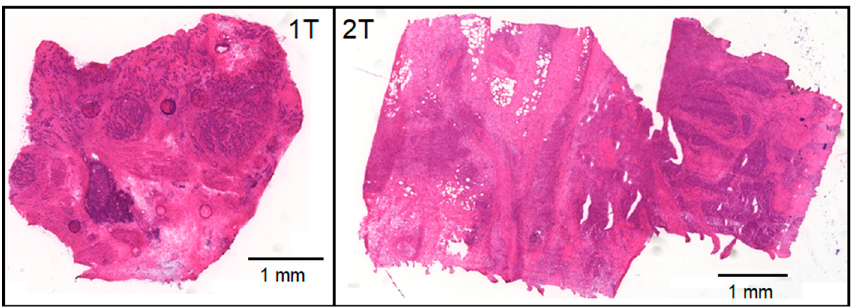
Figure 7. Hematoxylin and eosin stained tissue sections of samples 1T and 2T were cut adjacent to the surface of the specimens that were studied by Raman spectroscopic imaging.